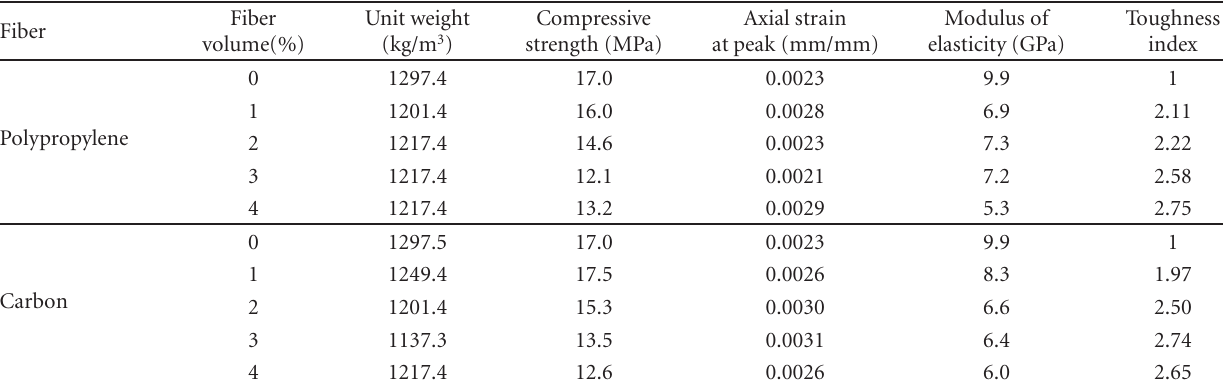
Table 6: Properties of fiber aerated lightweight concrete (0.1%